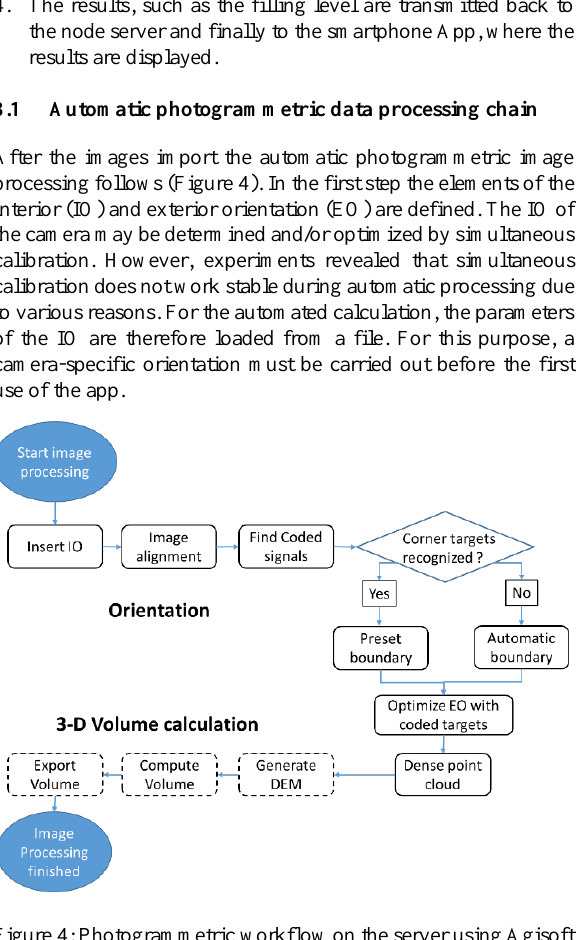
Figure 4: Photogrammetric workflow on the server using Agisoft Photoscan batch